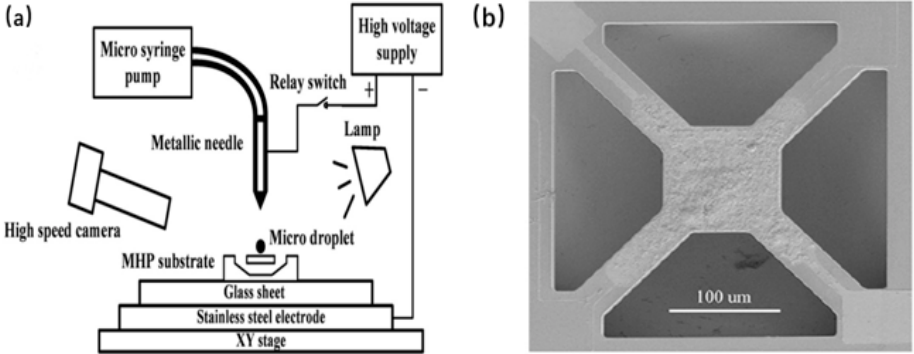
Figure 19. ( a ) EHD inkjet printing system. ( b ) Finished EHD printed micro hotplate surface [85].